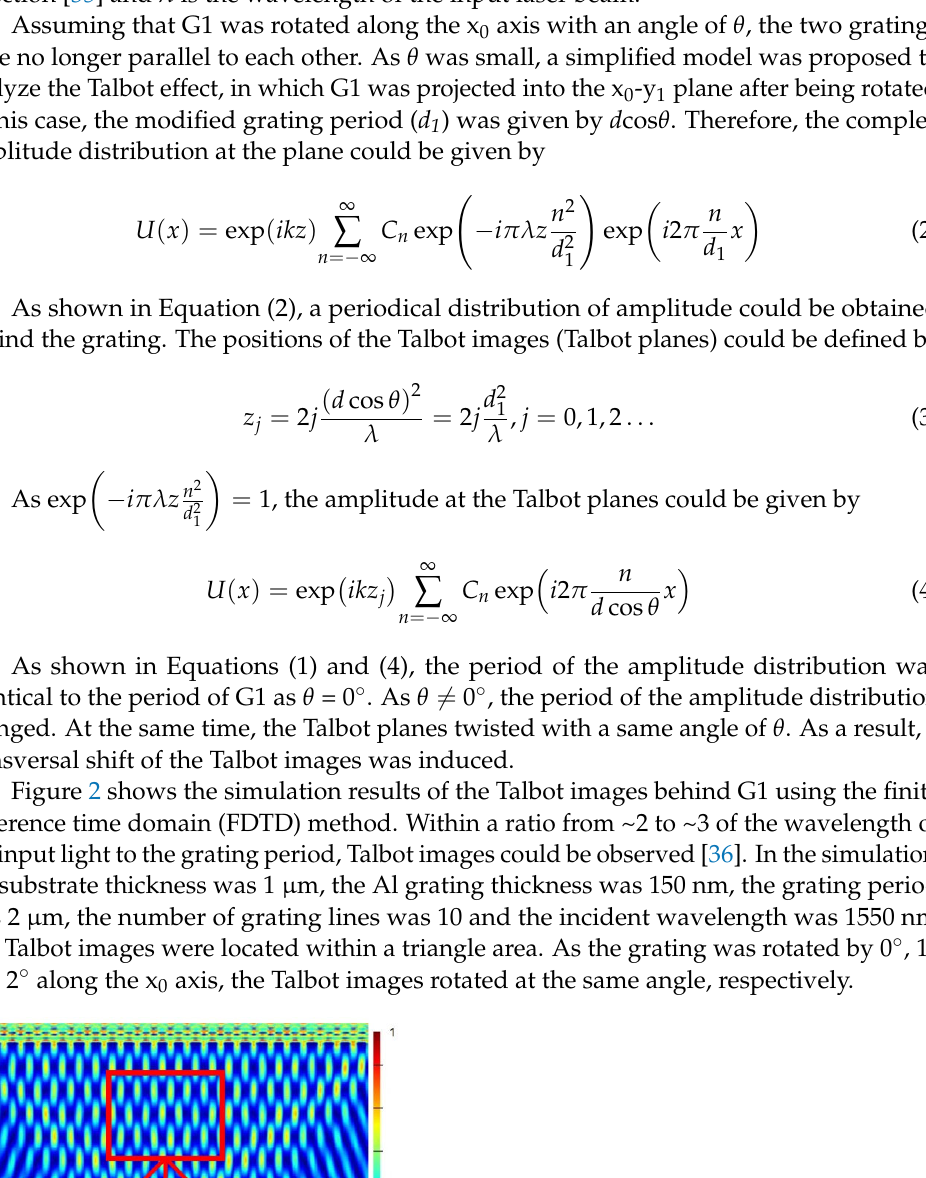
Figure 3. The relationship between the pitch angle and the shift of the Talbot image. The black dots indicate the simulated value of the transversal shift of the Talbot image. The red line indicates the linear fitting straight line (R 2 > 99%). In the simulation, the number of grating lines was 10 and the distance from the center of the Talbot image to G1 was L 1 = 4 μ m. The grating period of the lower grating (G2) was same as the period of G1. Assuming that the distance between G1 and G2 was Z , the complex amplitude distribution of the light field behind G2 could be expressed as [37]